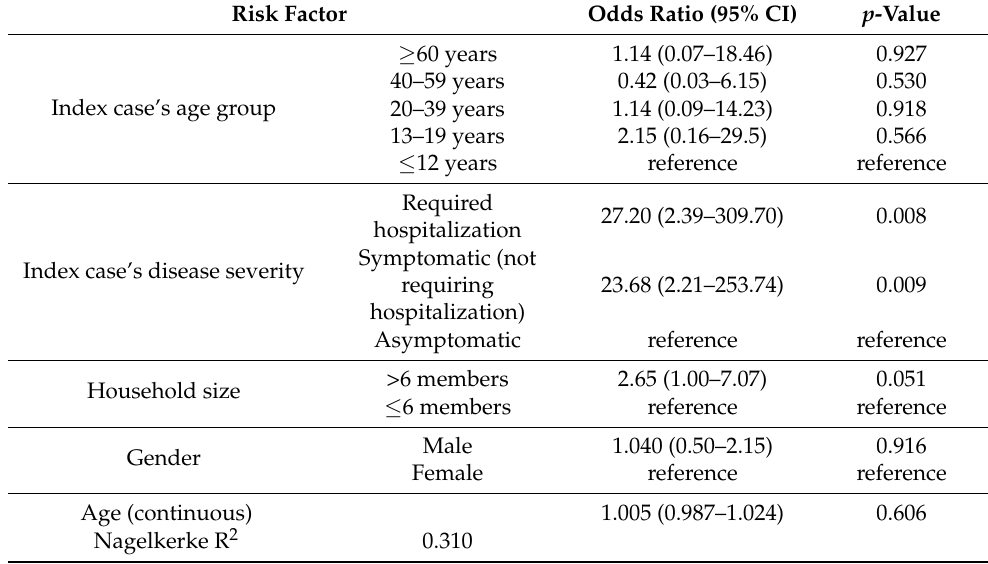
Table 4. Multivariable logistic regression analysis to determine risk factors for secondary